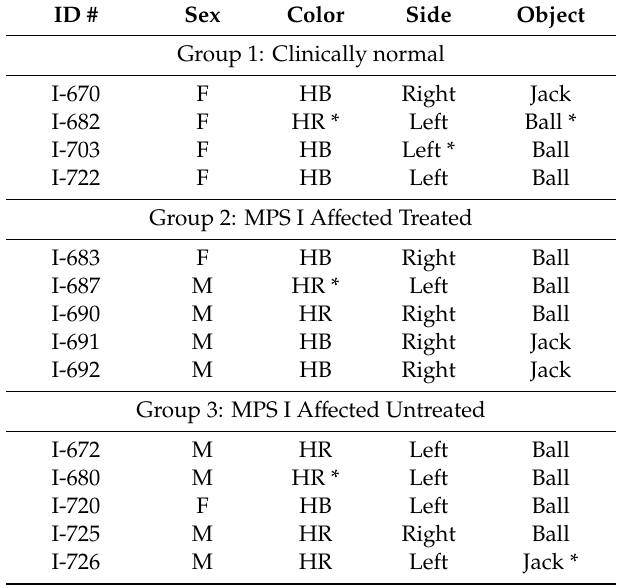
Table 2. Group preference evaluation results. Data presented for the selected preference of each individual for color, object, and side. HB = human perceived blue; HR = human perceived red. ID # Sex Color Side Object Group 1: Clinically